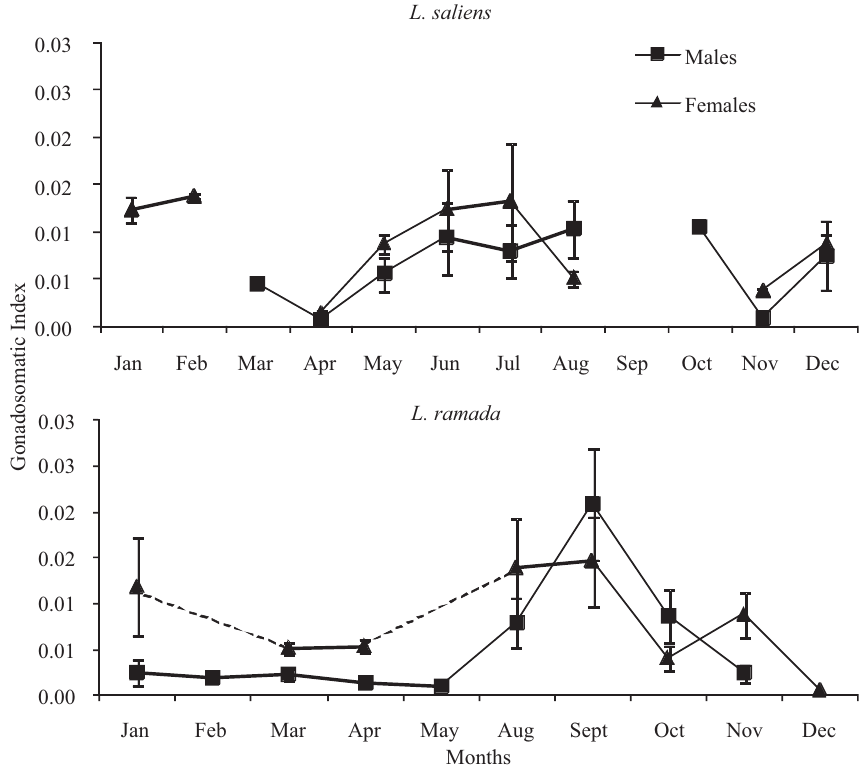
Fig. 3. Monthly variation of the gonadosomatic index (GSI) mean values of males and females of Liza saliens and Liza ramada caught during the sampling period (samples from different years were averaged